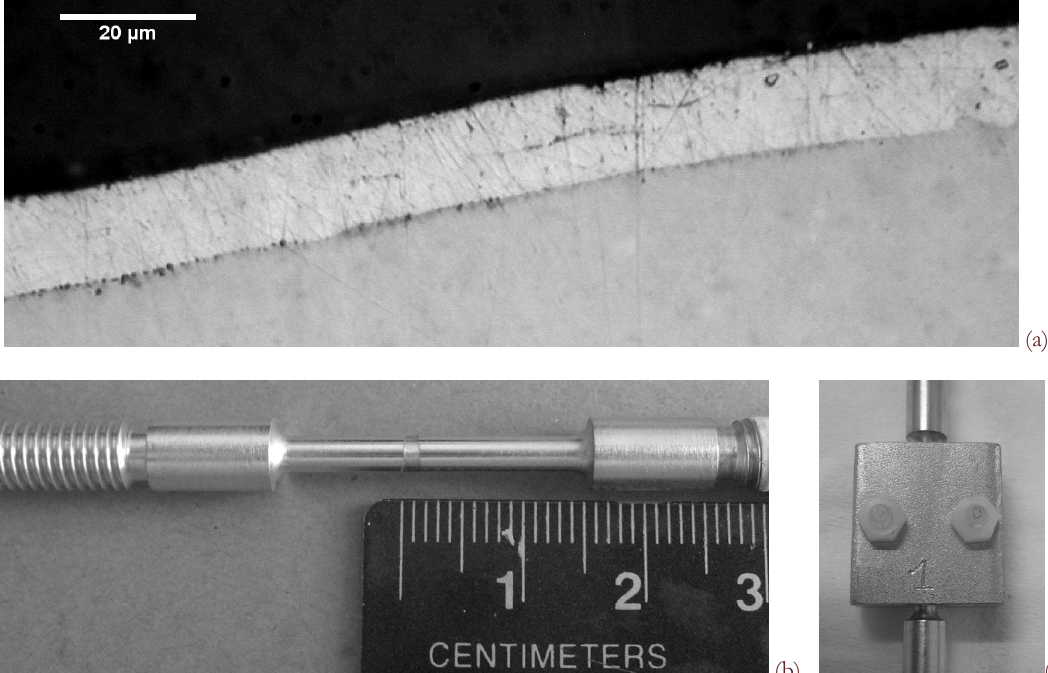
Figure 1: (a) Optical microscope picture of Zinc layer (500X), (b) Zinc coated round unnotched tensile specimen with the annular exposed steel area and (c) galvanic coupling made of AISI